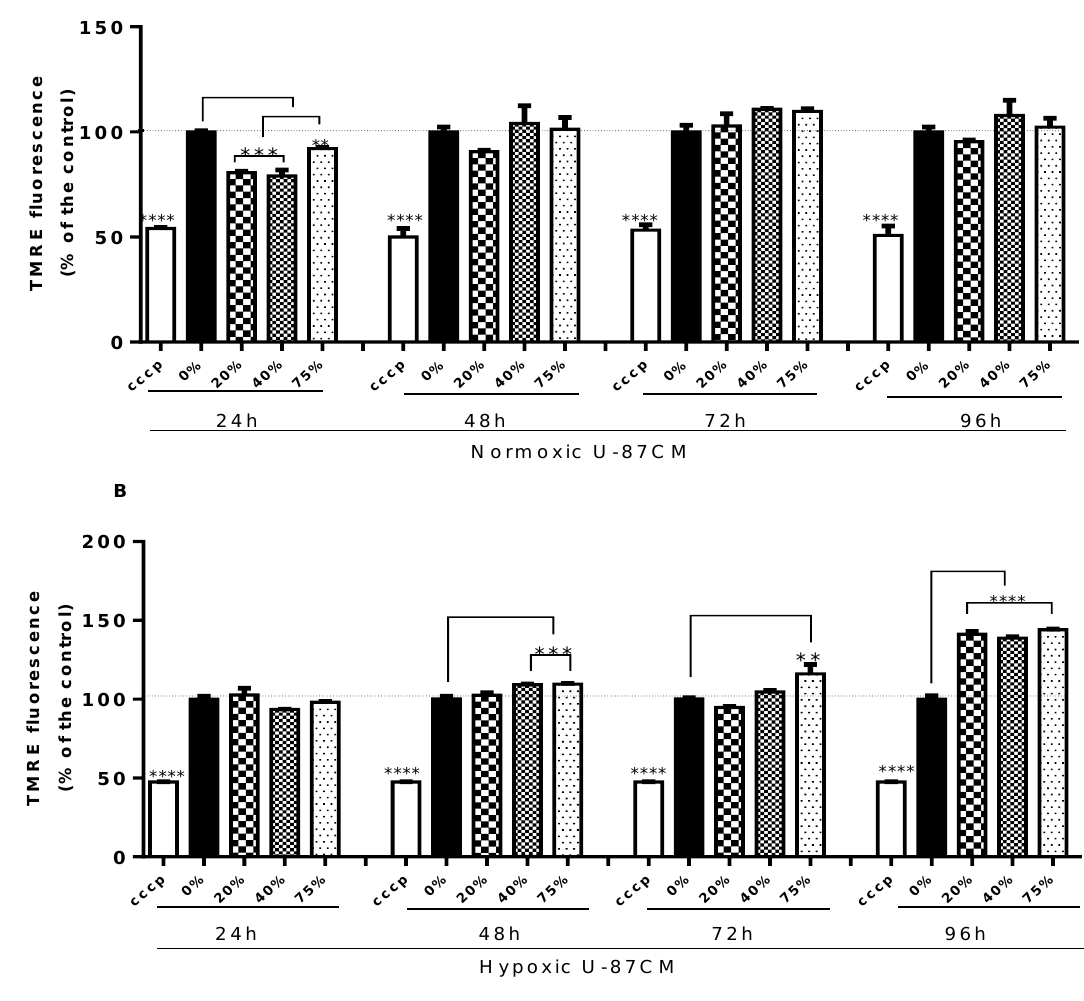
Figure 3. Graphs ( A , B ) show the changes in mitochondrial membrane potential ( ∆Ψ m) in bEnd.3 cells under the influence of glioblastoma U-87 cell-derived CM. ( A ) Shows mitochondrial membrane potential ( ∆Ψ m) in bEnd.3 cells after daily exposure to selected concentrations of glioblastoma U-87 conditioned media (U-87CM) derived from U-87 cells under normoxic conditions (21% O 2 ). ( B ) Shows the changes in mitochondrial membrane potential ( ∆Ψ m) in bEnd.3 cells after daily exposure to selected concentrations of conditioned media derived from U-87 cells under hypoxic conditions (5% O 2 ). CCCP: carbonyl cyanide 3-chlorophenylhydrazone, a known Ψ m depolarising agent, was used to decrease the mitochondrial membrane potential (negative control) (** p < 0.01, *** p < 0.001, **** p < 0.0001), ( n =